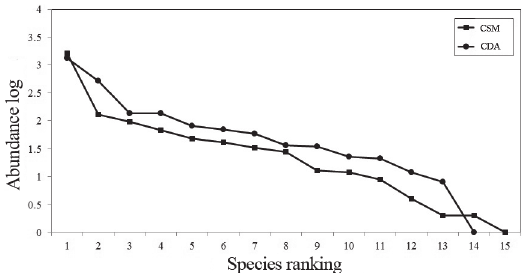
Figure 2 - Rarefaction curve of species of anurans recorded in the areas CDA and CSM, located in the mid northern region of the state of Paraná, between September 2011 and March 2012. Intervals of 95% confidence are represented by dotted lines.